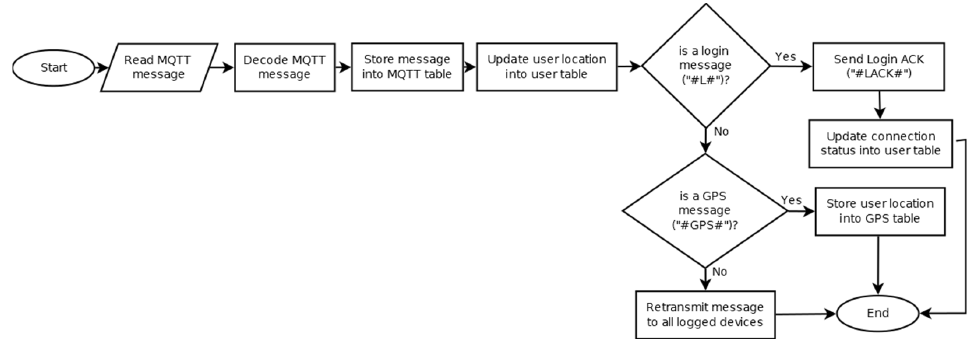
Figure 7. FlowGraph of message processing on the TeamUp server.